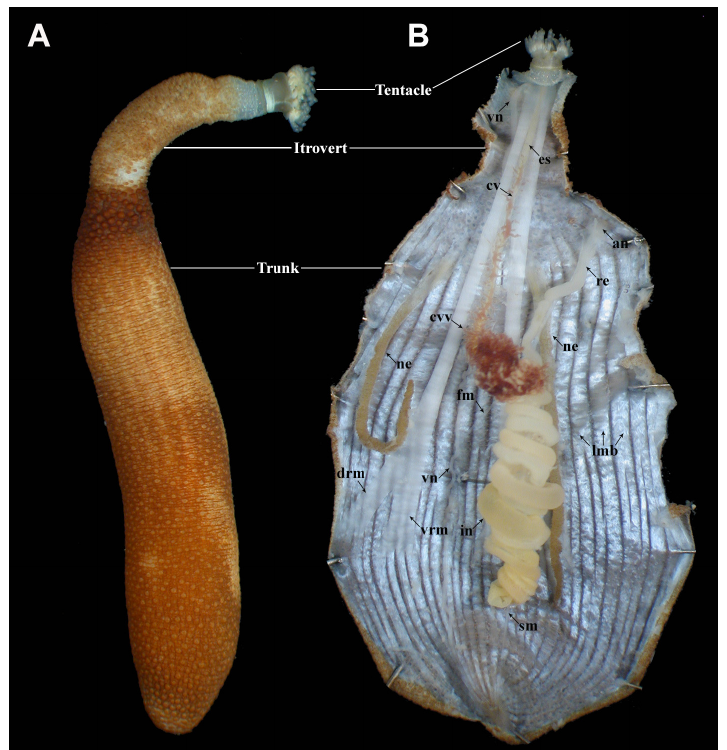
Figure 3. Sipuncula external and internal anatomy. ( A ) Antillesoma antillarum : external view. ( B ) A. antillarum : internal view. Abbreviations: an = anus, cv = contractile vessel, cvv = contractile vessel villi, drm = dorsal retractor muscle, es = esophagus, fm = fixing muscle, in = intestine, lmb = longitudinal muscle band, ne = nephridia, re = rectum, sm = spindle muscle, vn = ventral nerve cord, vrm = ventral retractor